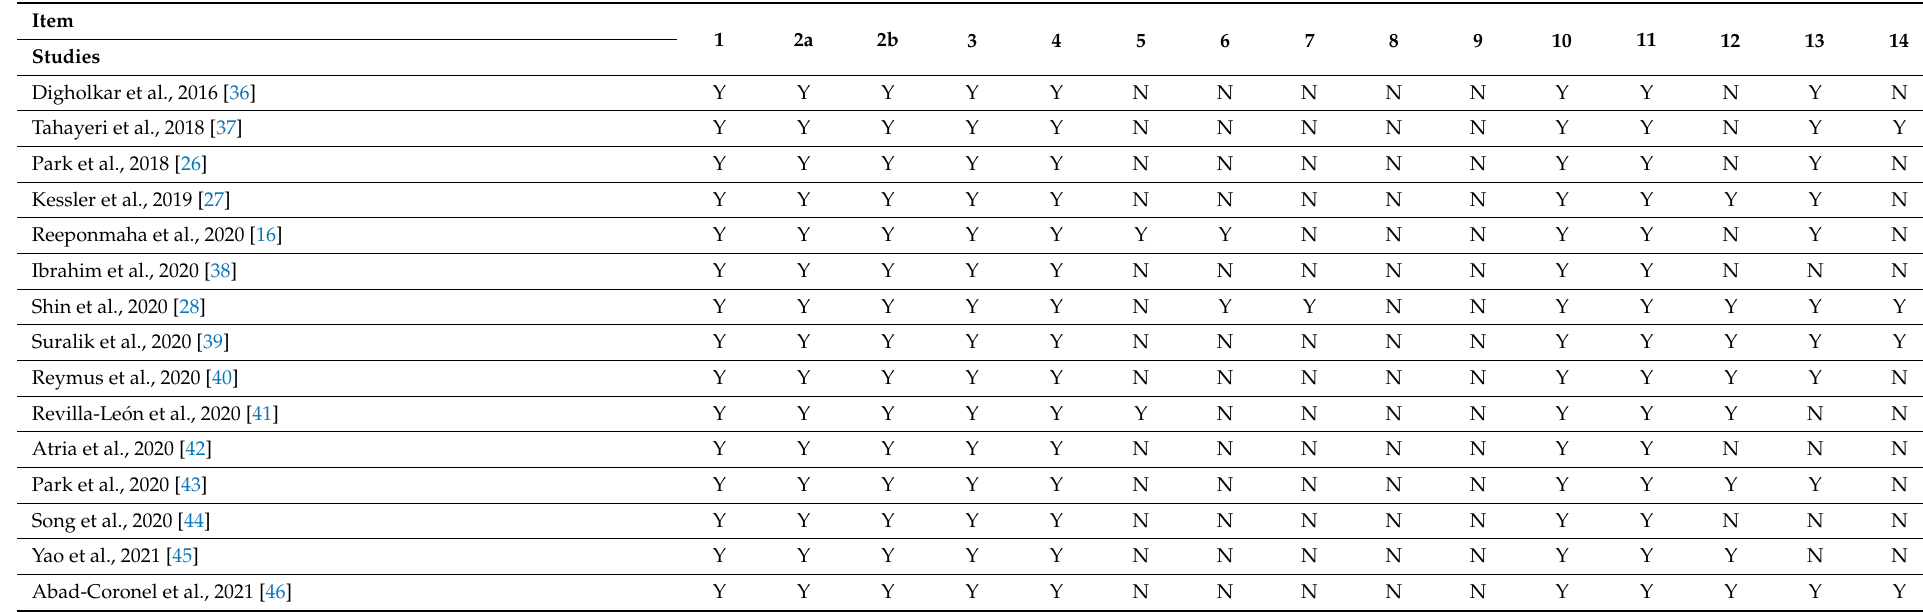
Table 4. Quality analysis results of the included